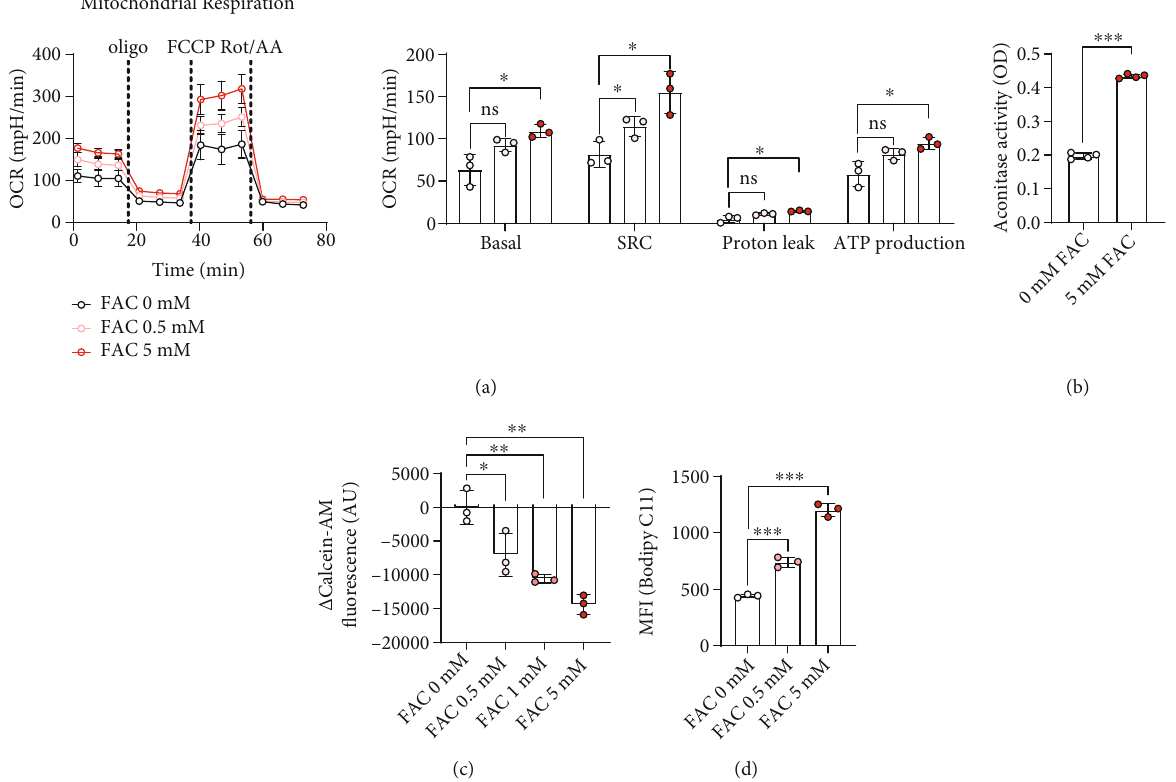
Figure 3: E ff ects of FAC on mitochondrial function. 1 × 10 6 cells/mL BMDMs were stimulated with indicated concentrations of FAC for 16h. (a) The OCR was measured using a Seahorse XF-96 Flux Analyzer. The scatterplot with the bar graph illustrates calculated respiratory parameters. (b) Aconitase activity was measured by ELISA, and (c) the amount of intracellular labile iron was given as the delta ( Δ ) of the fl uorescence to initial fl uorescence. (d) The amount of lipid peroxidation was estimated by the mean fl uorescence intensity (MFI) of C11-BODIPY using fl ow cytometry. ∗ indicates signi fi cant di ff erences ( ∗ P < 0 : 05 , ∗∗ P < 0 : 01 , and ∗∗∗ P < 0 : 001 ) from the control